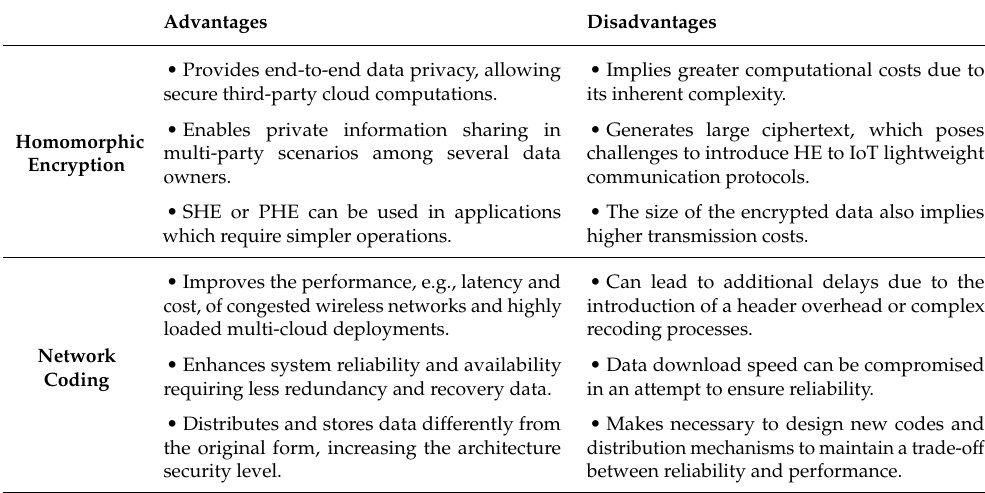
Table 1. Overview of the benefits and drawbacks of NC and HE